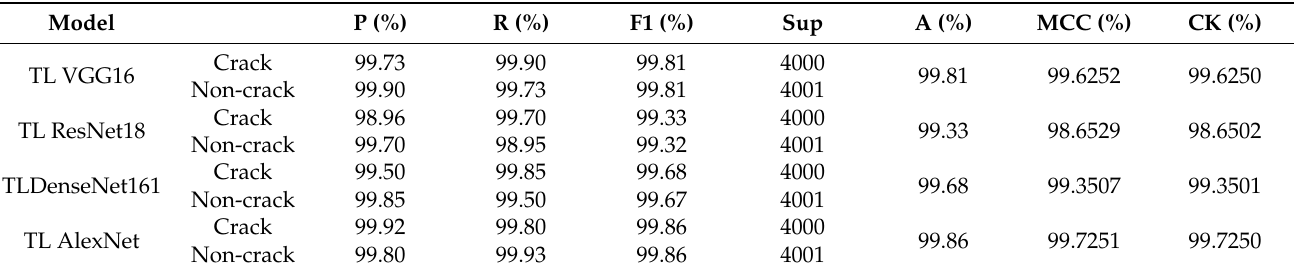
Table 3. Various scores were calculated in the test dataset (CCIC) for different TL models after 30 epochs of training where P = Precision, R = Recall, F1 = F1-score, Sup = Support, A = Accuracy, CK = Cohen’s Kappa.